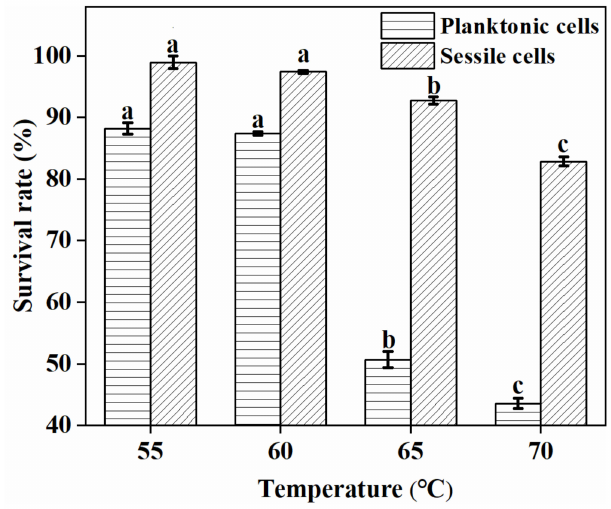
Figure 10. The effects of temperature on the viability of cells in planktonic and biofilm modes. Significant differences ( p < 0.05) are indicated by different letters (a, b, and c).